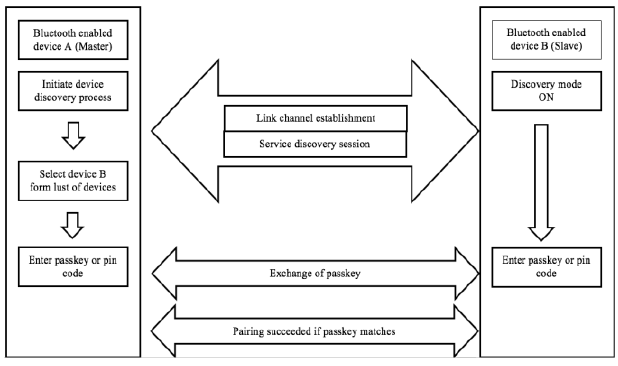
Fig. 2. The Bluetooth pairing process with master- slave architecture.